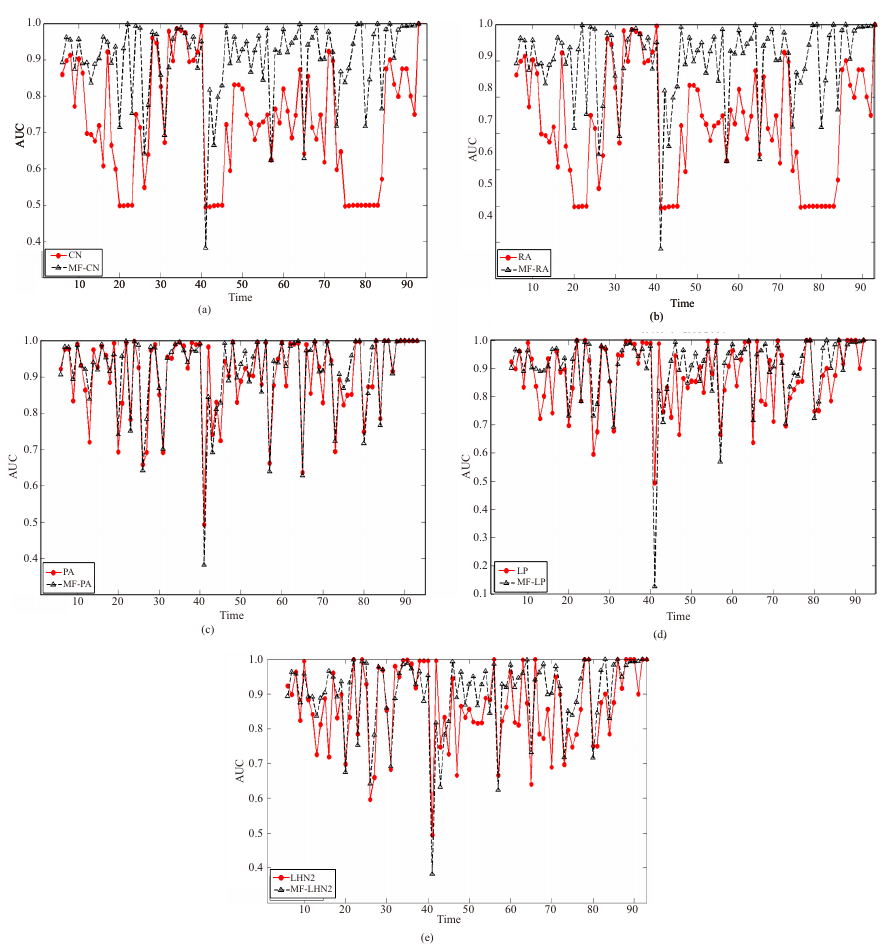
Fig. 7 Performance of different methods on